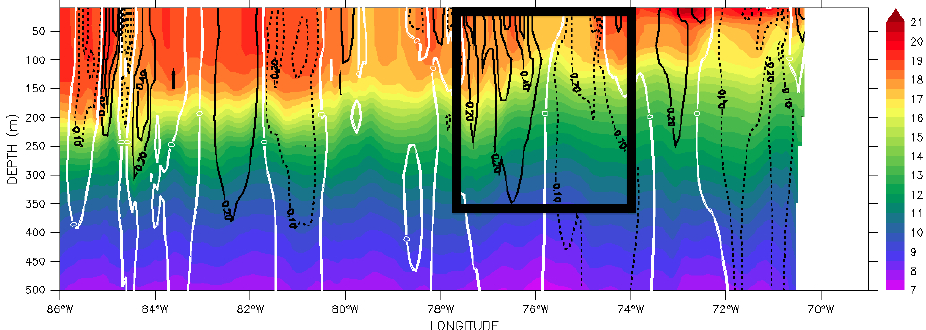
Fig. 13. Vertical temperature (in ◦ C) profiles (color) and meridional velocity (ms − 1 , line contours) with positive values (continuous lines) and negative values (dashed lines) for 10 November revealing the eddy structure in depth. The profile is plotted at 20 ◦ S from 86 to 69 ◦ W.